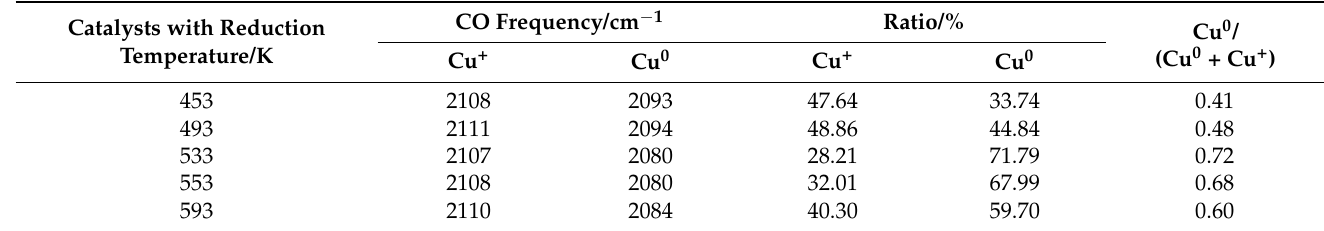
Table 5. CMA-L in situ FTIR of the adsorbed CO method’s peak fitting results. Catalysts with Reduction